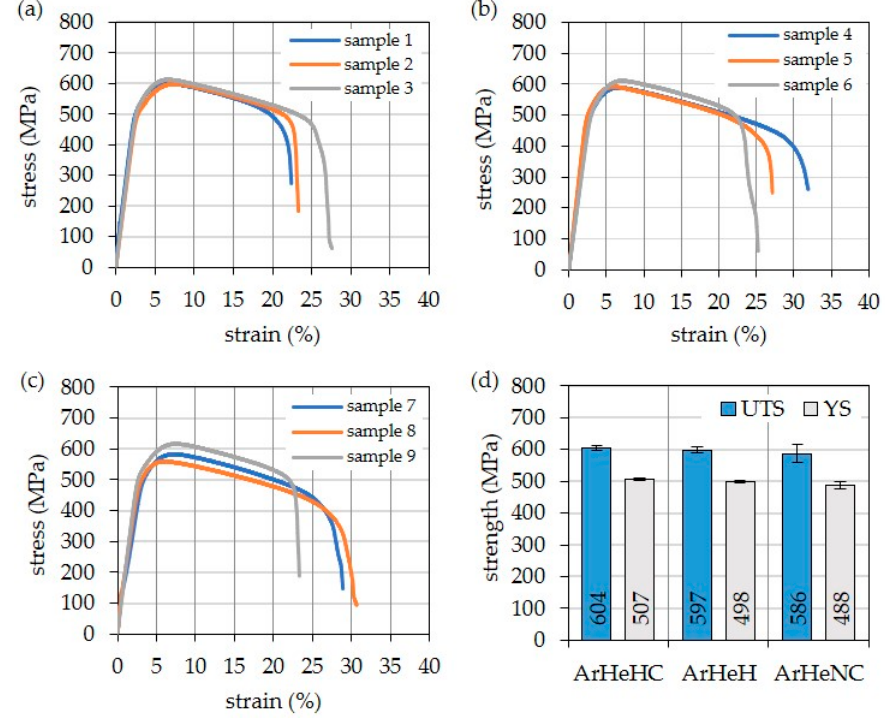
Figure 16. Results of hot tensile tests at 871 °C. ( a ) ArHeHC; ( b ) ArHeH; ( c ) ArHeNC; ( d ) comparison of the arithmetical mean values.